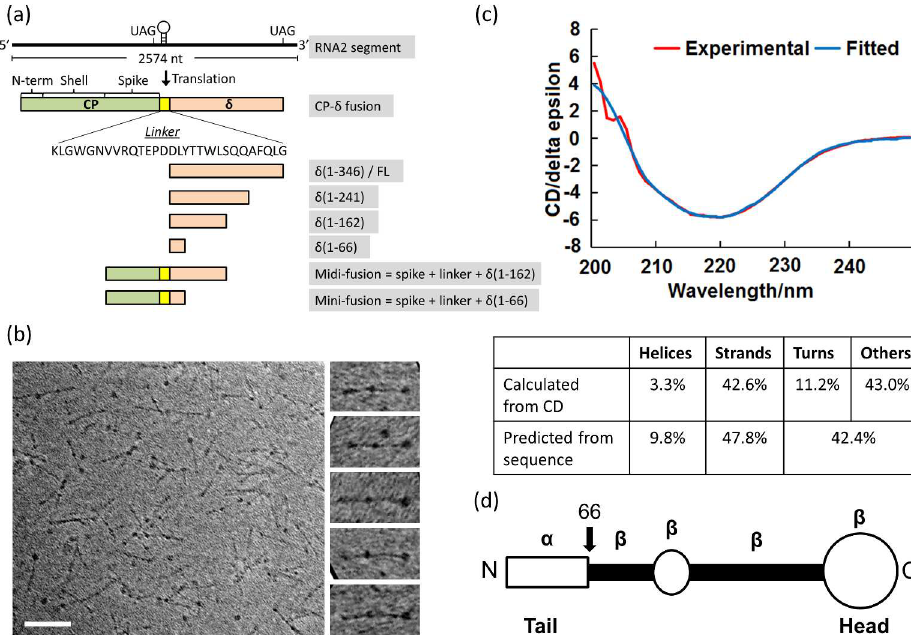
Fig 1. Orsay δ protein. (a) The coding scheme of Orsay δ and CP- δ fusion protein. CP- δ , which is produced by ribosomalframeshifting, is comprisedof the full-lengthCP, a 29-aa linker, and the full-length δ . The Orsay CP can be dividedinto three parts, the N-terminal peptide, shell, and the spike domain.The five δ and CP- δ truncation mutants are shown below. (b) TEM images of δ by negativestaining.On the right are five enlarged δ alignedin the horizontal direction. Scale bar, 500 Å . (c) CD spectra of δ . The experimental data and the fitting curves are shown in red and blue, respectively.The table below comparesthe secondarystructure contents calculatedfrom CD and sequence-based prediction. (d) δ domain map. There is a slightly enlarged tail domainat the N-terminus (aa1-66),a small globulardomain in the middle,and a large globularhead at the